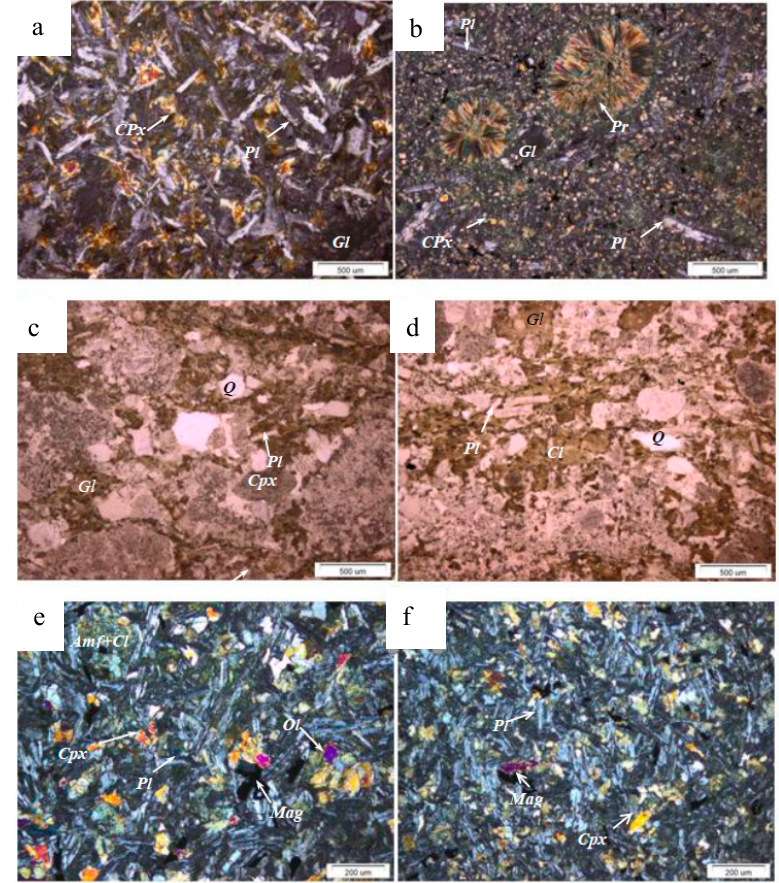
Figure 7. Photomicrographs of the volcanic rocks in the Khalil area. ( a , b ) Syverminsky formation; ( a ) tholeiitic basalt (sample X-24), ( b ) amygdaloidal basalt (sample X-26); ( c , d ) Syverminsky formation, tuffs (sample X-39); ( e , f ) Gudchikhinsky formation, olivine-bearing basalts (sample X-27) ( e ) sheaf-shaped texture, ( f ) ophitic texture. Minerals: Ol : olivine, Cpx : clinopyroxene, Pl : plagioclase, Cl : chlorite, Amf : amphibole, Pr : prehnite, Mag : magnetite; Gl : glass. Scale bars, µ m: a–d—500,